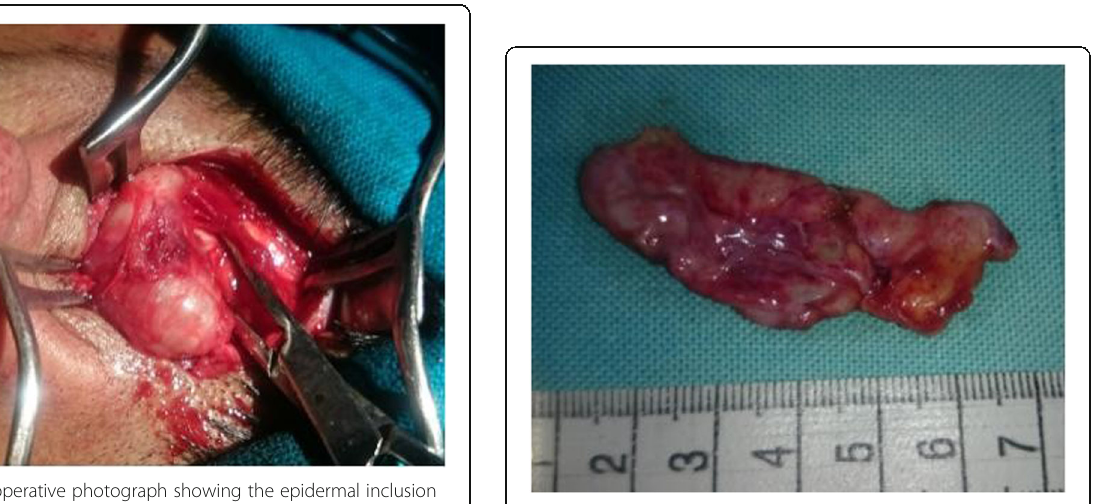
Fig. 3 Postoperative picture of epidermal inclusion cyst excised in